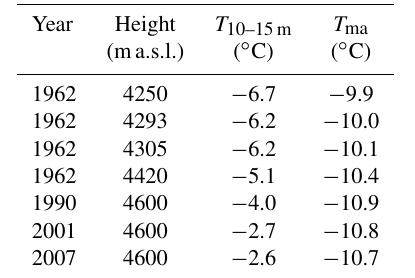
Table 2. Measured ice temperatures of the Grigoriev ice cap at 10– 15m depth from 1962 (Dikikh et al., 1965), 1990 (Thompson et al., 1993), 2001 (Arkhipov et al., 2004), and 2007 (Takeuchi et al., 2014). T ma represents the mean annual air temperature at the con- sidered surface elevation of the 15 years prior to each individual